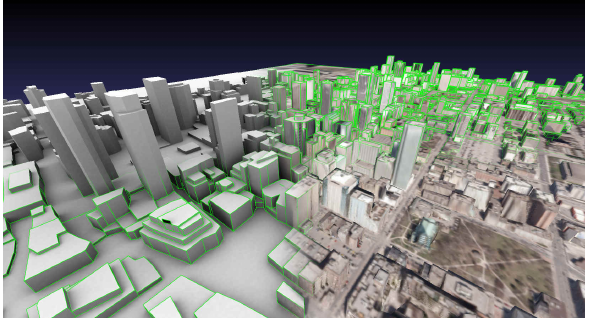
Figure 1. This paper applies a fully-automatic pipeline to obtain a simplified mesh from a given dense point cloud. The data shown in the figure is part of the evaluation dataset discussed in Section